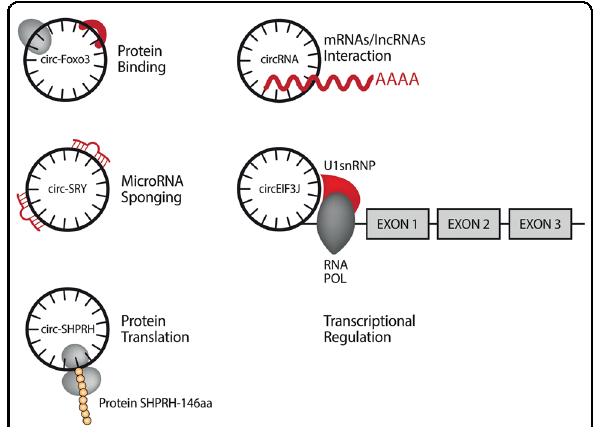
Fig. 1 circRNA functions. CircRNAs can interact with proteins and other RNAs, acting as microRNA sponge, regulate the transcription and in some cases they can also be translated in